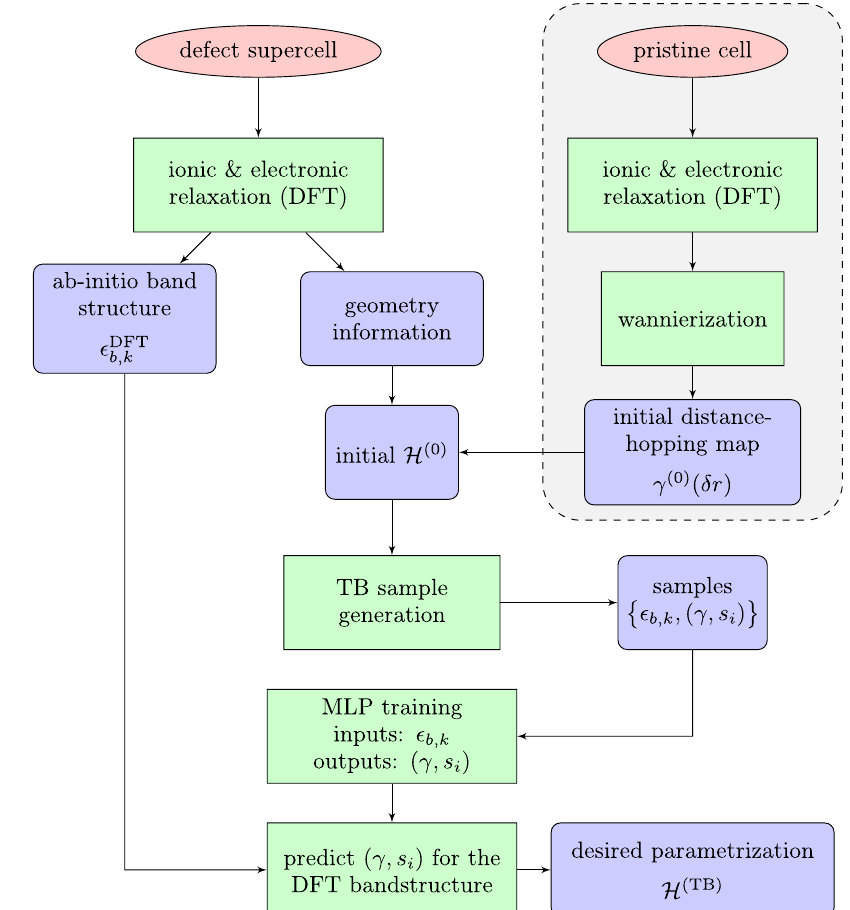
Fig. 3 Schematic fl ow chart of ML algorithm. Produces a machine-learned TB parametrization of a defect system. The hued section on the right can be replaced with an initial γ (SK) from Slater – Koster theory for materials with challenging bulk cells. Cornered green nodes represent calculation processes and rounded blue nodes represent